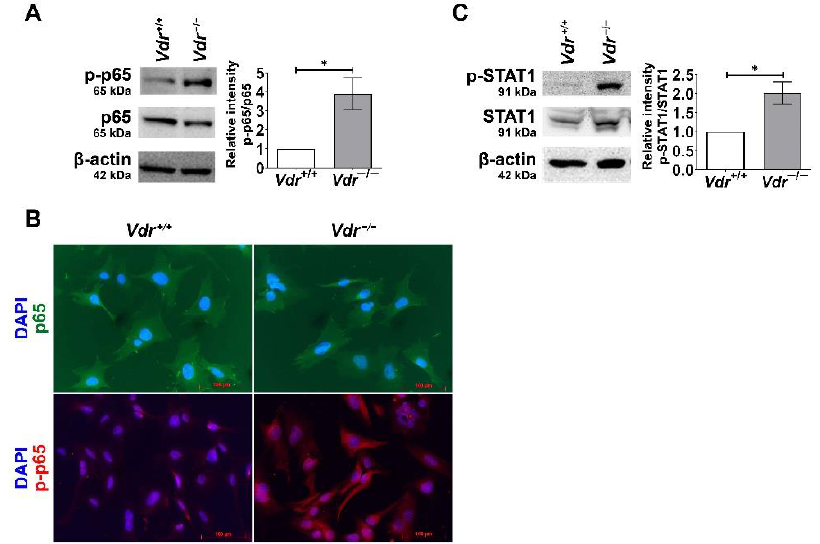
Figure 7. Upregulated activities of pro-inflammatory transcription factors in Vdr −/− retinal EC. ( A ) phosphorylated NF- κB (p-p65) and NF- κB (p65) levels in Vdr +/+ and Vdr −/− retinal EC were deter- mined by Western blot analysis with specific antibodies. (n = 4, * p < 0.05) ( B ) Indirect immunofluo- rescent staining of p65 (green), p-p65 (red), and nuclei (blue) was performed to demonstrate locali- zation of NF- κB. ( C ) Phosphorylated STAT1 and STAT1 levels in Vdr +/+ and Vdr −/− retinal EC were determined by Western blot analysis with specific antibodies (n = 4, * p < 0.05).